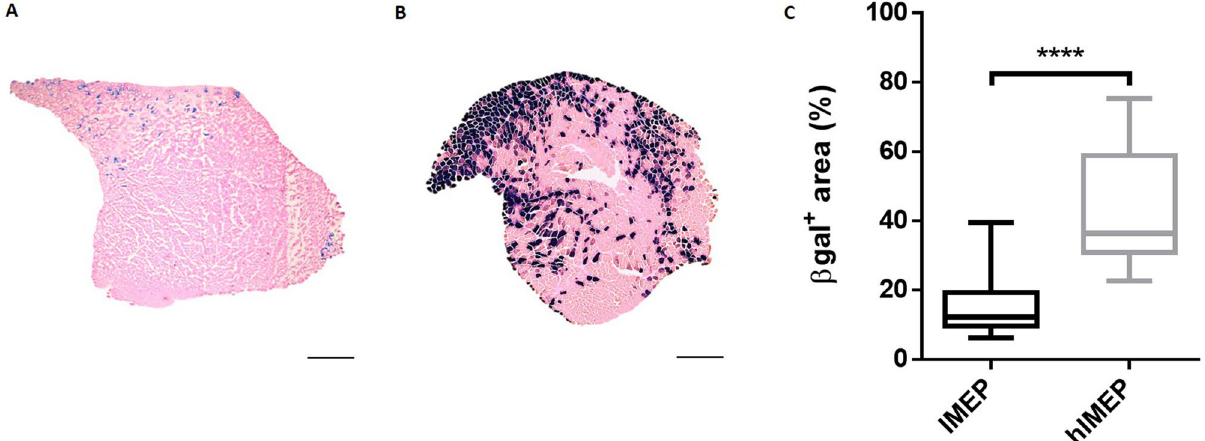
Figure 1. Hyaluronidase pre-treatment improves β-galactosidase expression in mouse Tibialis Anterior muscle (TA). ( A , B ) Representative sections of TA electroporated ( A ) without hyaluronidase pre-treatment (IMEP) or ( B ) with hyaluronidase pre-treatment 2 h before the electroporation procedure (hIMEP). TA muscles were injected by IMEP or hIMEP with 40 µg of pCMV-lacZ reporter plasmid. TA were harvested 1-week post- injection and cryosections stained with X-gal (blue) and counterstained with Eosin (pink). Scale 500 µm. ( C ) Percentage of surface area expressing β-galactosidase (β-gal + ) quantified by color thresholding using ImageJ. Data are represented as boxplots, ****p < 0.0001 Mann–Whitney Rank Sum Test; n = 4 for each group. The graph was generated using GraphPad Prism